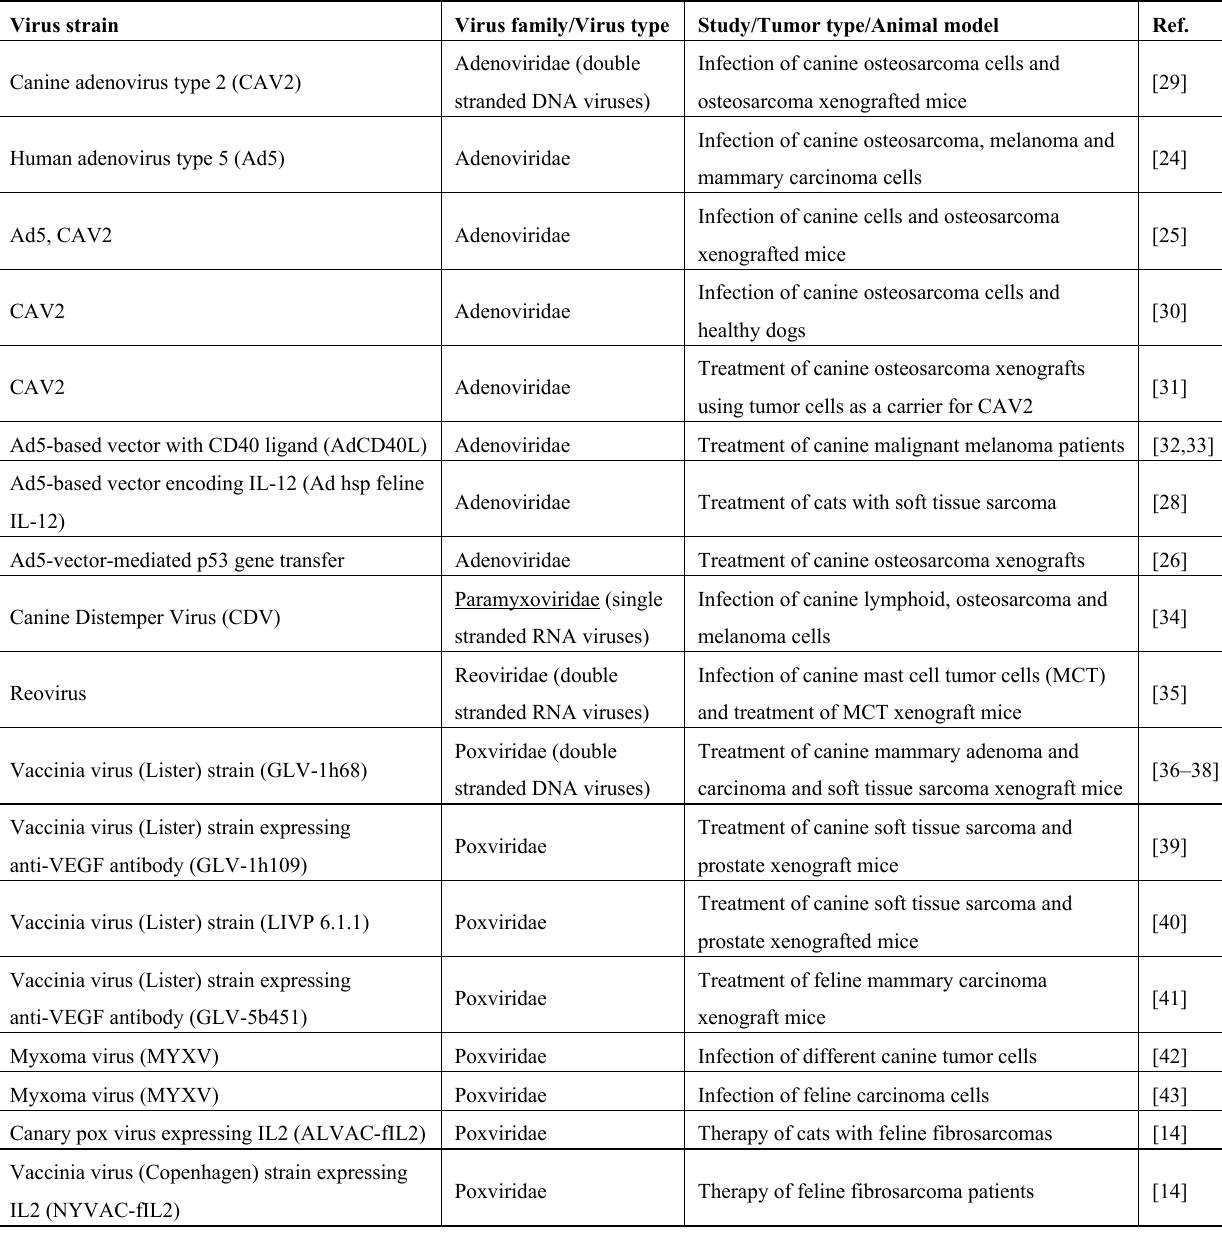
Table 1. Oncolytic viruses tested for canine and/or feline cancer